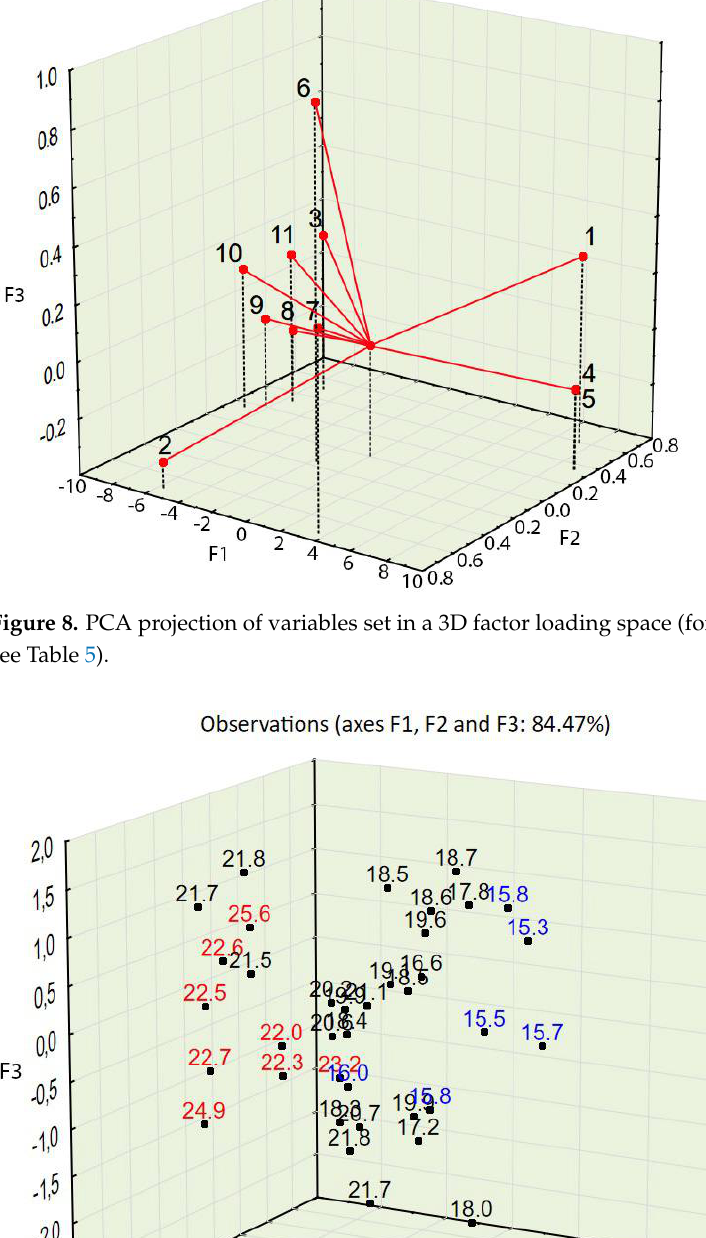
Figure 7. PCA with object grouping in a two-dimensional space on the basis of concrete composi- tion in relation to concrete properties. Splitting tensile strength: red represents a strength over 2.5 MPa, and blue represents a strength below 2.10 MPa.